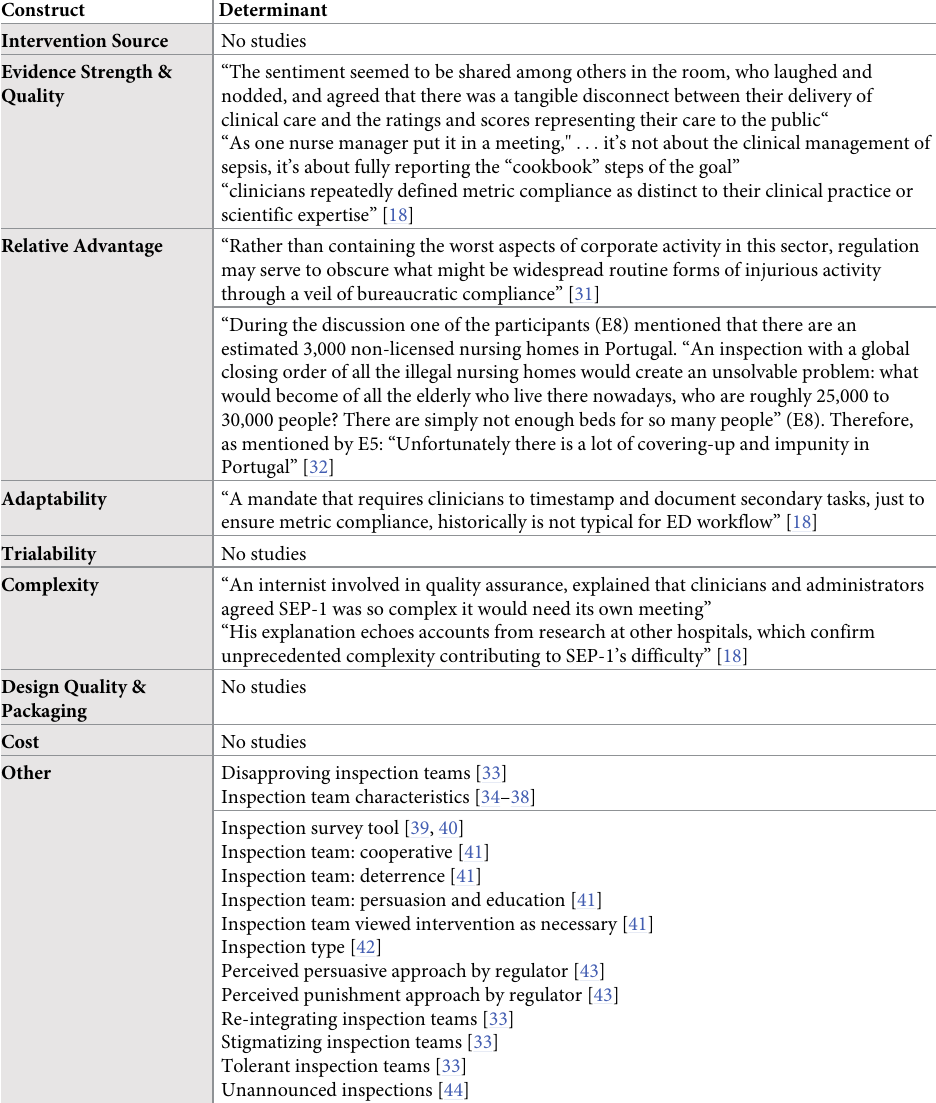
Table 2. Determinants coded to the intervention characteristics